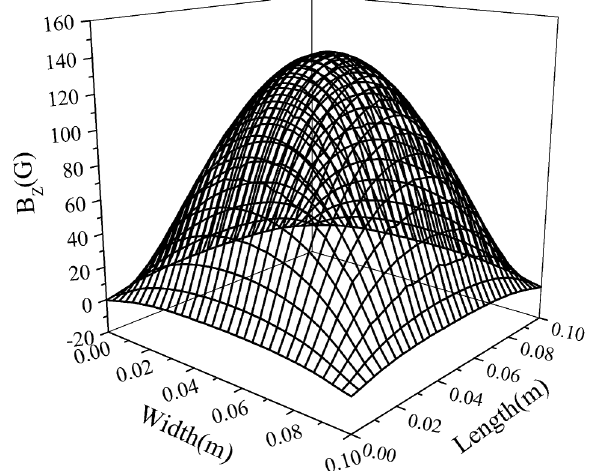
FIG. 7. 2D plot of the vertical component of the field due to the eddy current flow in the SS plate for 50 Hz frequency at a distance z ¼ 10 mm from the plate.